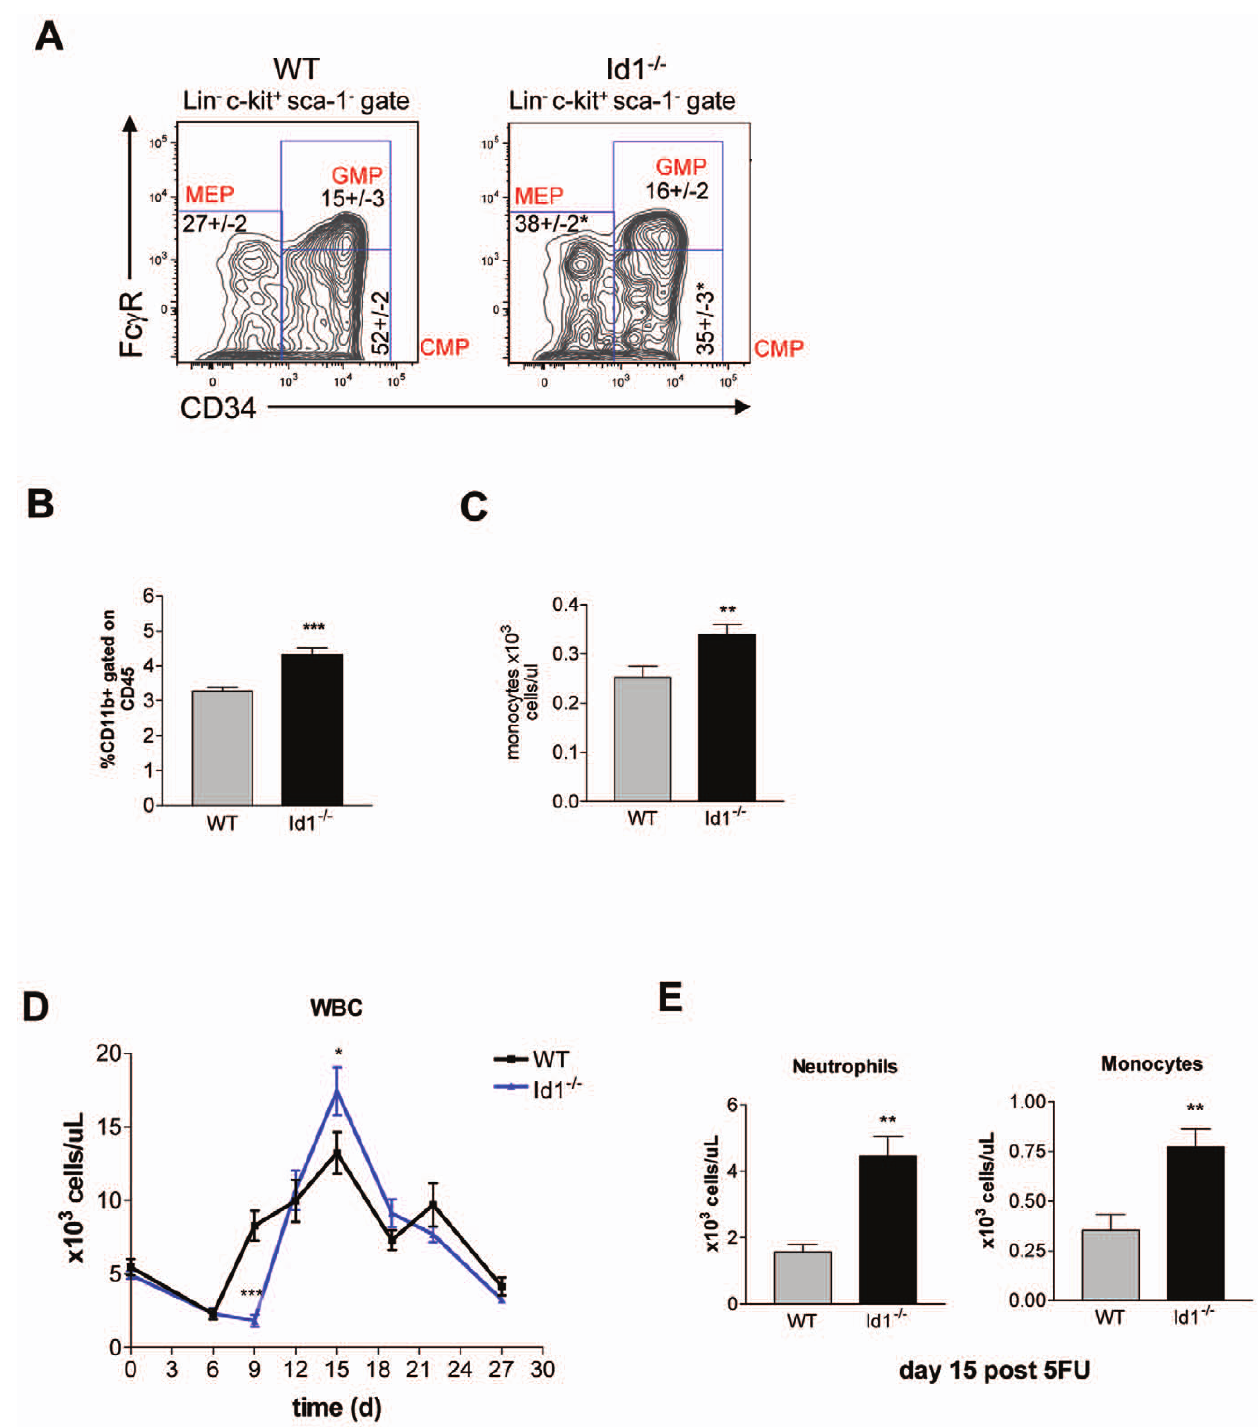
Figure 3. Enhanced myeloid differentiation in Id1 2 / 2 mice. (A) Representative flow-cytometric profiles of myeloid progenitor populations (CMP, GMP, MEP) in wild-type and Id1 2 / 2 BM (n=6). (B) Monocytes in the BM were measured by flow cytometry using antibodies against CD11b and CD45 (n=8). (C) Monocytes in the blood were measured by a complete blood count test (n=40). (D) White blood cell (WBC) counts in wild-type and Id1 2 / 2 mice during hematopoietic challenge. Mice were given a single injection of 5-FU and bled every 3 days (n=5). (E) Monocyte and neutrophil counts measured 15 days after 5-FU injection (n=5). (A–E) *P , 0.05, **P , 0.01, ***P , 0.001. Error bars represent 6 S.E.M.